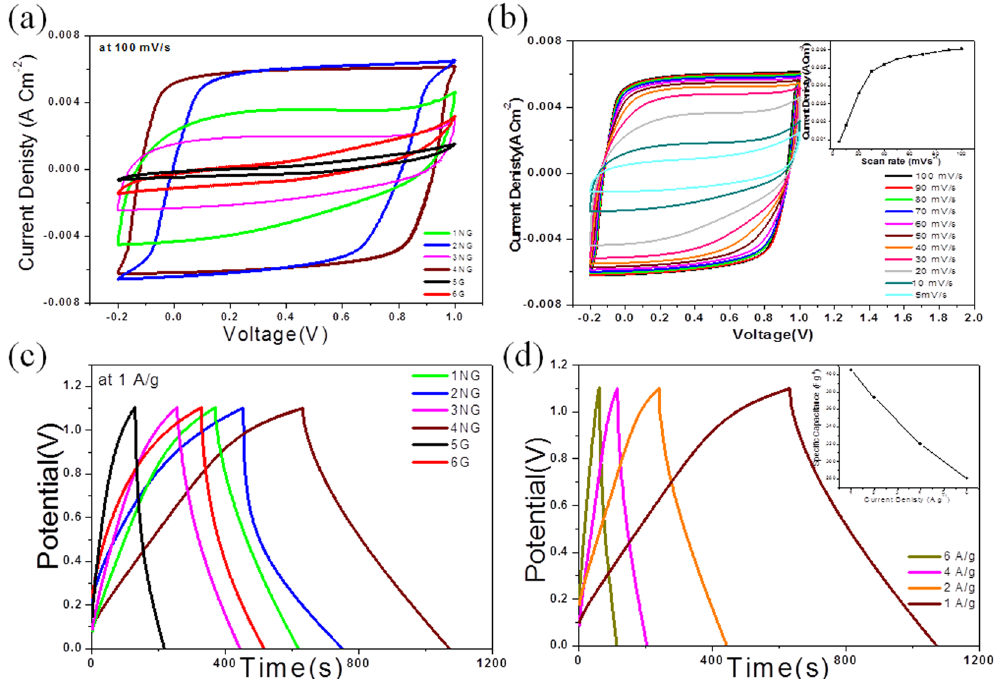
Figure 3. Electrochemical performance of the prepared samples. ( a ) CV curves at 100 mV s − 1 in 6 M KOH and ( b ) CV curve for 4NG at different scan rates (inset shows the current densities are linearly grown with increasing scan rate), ( c ) Galvanostatic charge discharge curves at 1 A g − 1 in 6 M KOH and ( d ) for 4NG at different scan rates(inset shows the effect of increasing the current density on the specific